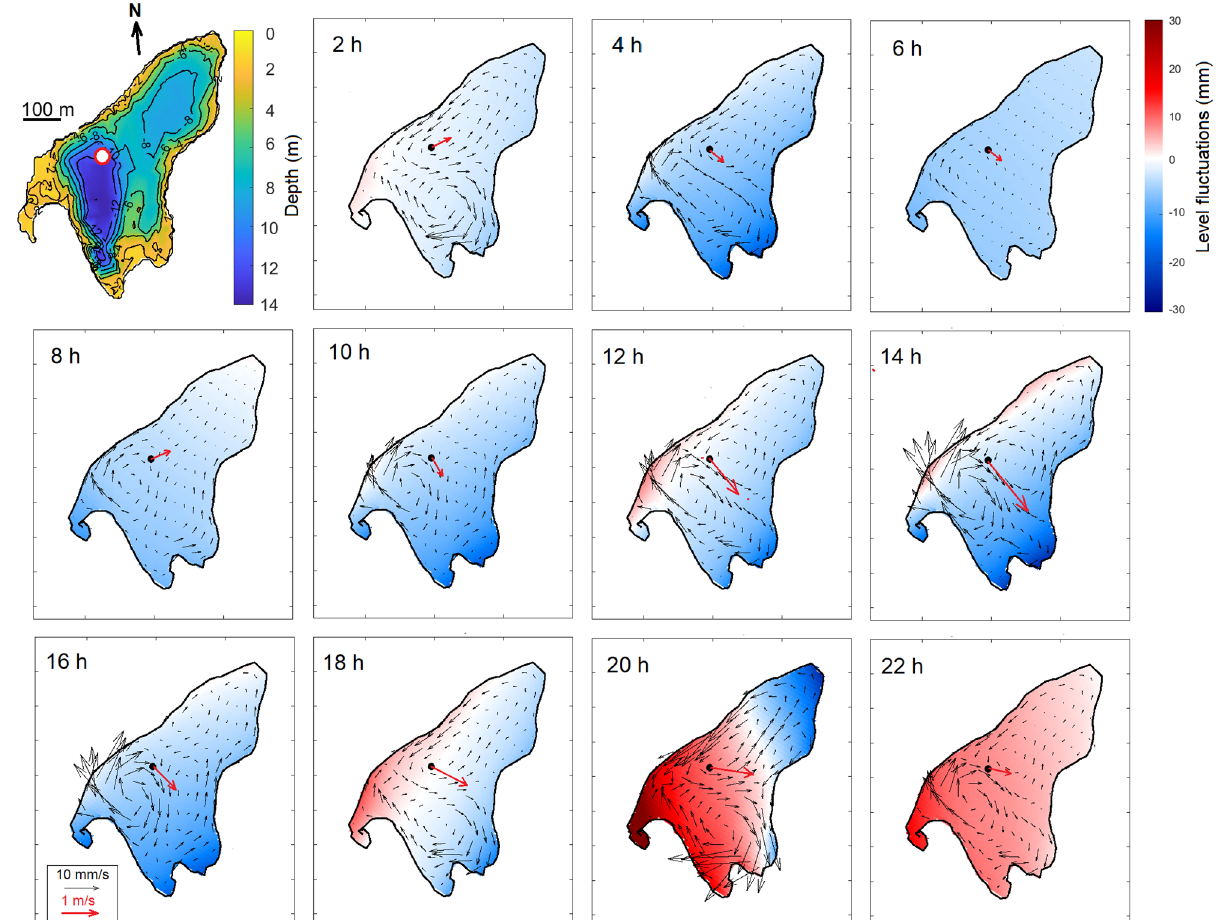
Figure 8. Modeling results of currents and level fluctuation in Lake El Sol from observations of wind and air temperature on 5 September 2018. In the upper left, a bathymetric map of the lake shows the floating meteorological station marked with a white circle (in the rest of the figures, the position of the weather station is marked with a black dot). The remaining rectangles show simulated currents and level fluctuations every two hours. In the lower left, black and red pattern arrows indicate the corresponding scales of current velocities and measured wind.